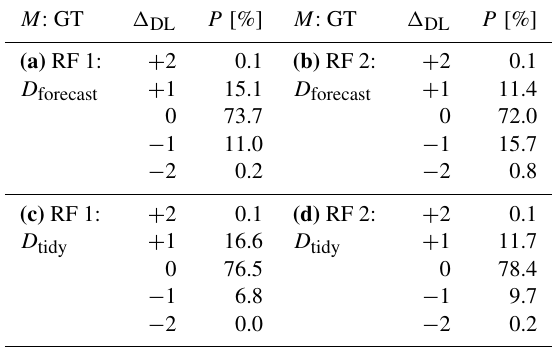
Table 2. Model ( M ) used for training and ground truth (GT) labels of the test set, bias ( (cid:49) DL ), and the proportion of samples ( P ) for each bias value. Both models are evaluated on the D forecast test set (upper part) and D tidy test set (lower